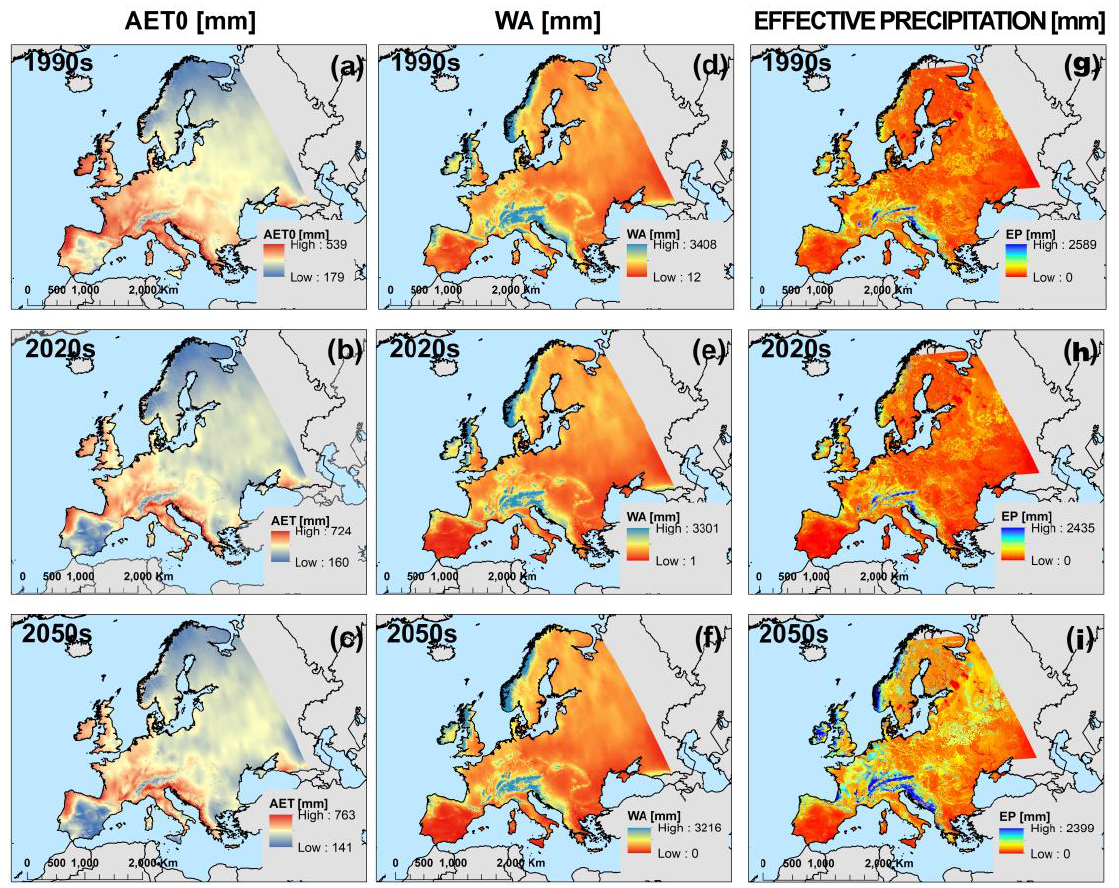
Figure 7. Variables list as input data in Europe and output results including actual evapotranspiration, (AET0), water availability (WA), and effective precipitation. ( a ) Actual evapotranspiration AET0 in 1990s. ( b ) Actual evapotranspiration AET0 in 2020s. ( c ) Actual evapotranspiration AET0 in 2050s. ( d ) Water availability WA in 1990s. ( e ) Water availability WA in 2020s. ( f ) Water availability WA in 2050s. ( g ) Effective precipitation in 1990s. ( h ) Effective precipitation in 2020s. ( i ) Effective precipitation in 2050s.